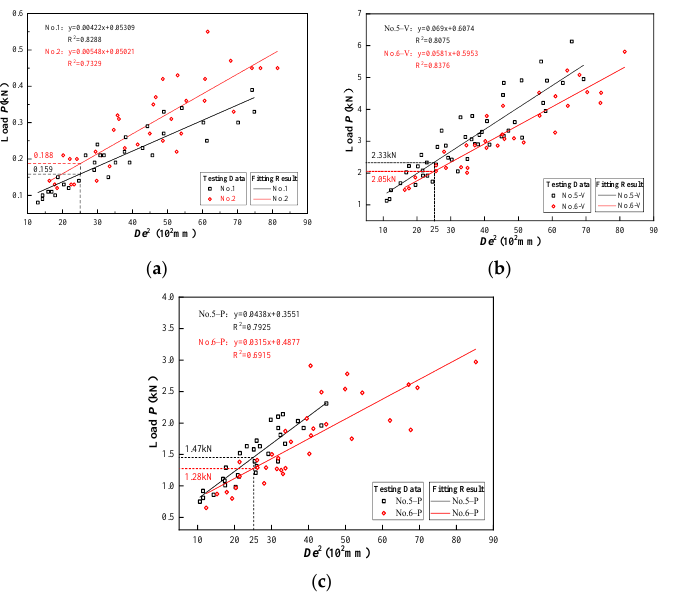
Figure 5. P - D e2 fitting curve of carbonaceous slate in the Luang Prabang Suture Zone: ( a ) Lump structure; ( b ) layer structure loaded perpendicular to lamina plane; ( c ) layer structure loaded parallel to lamina plane.